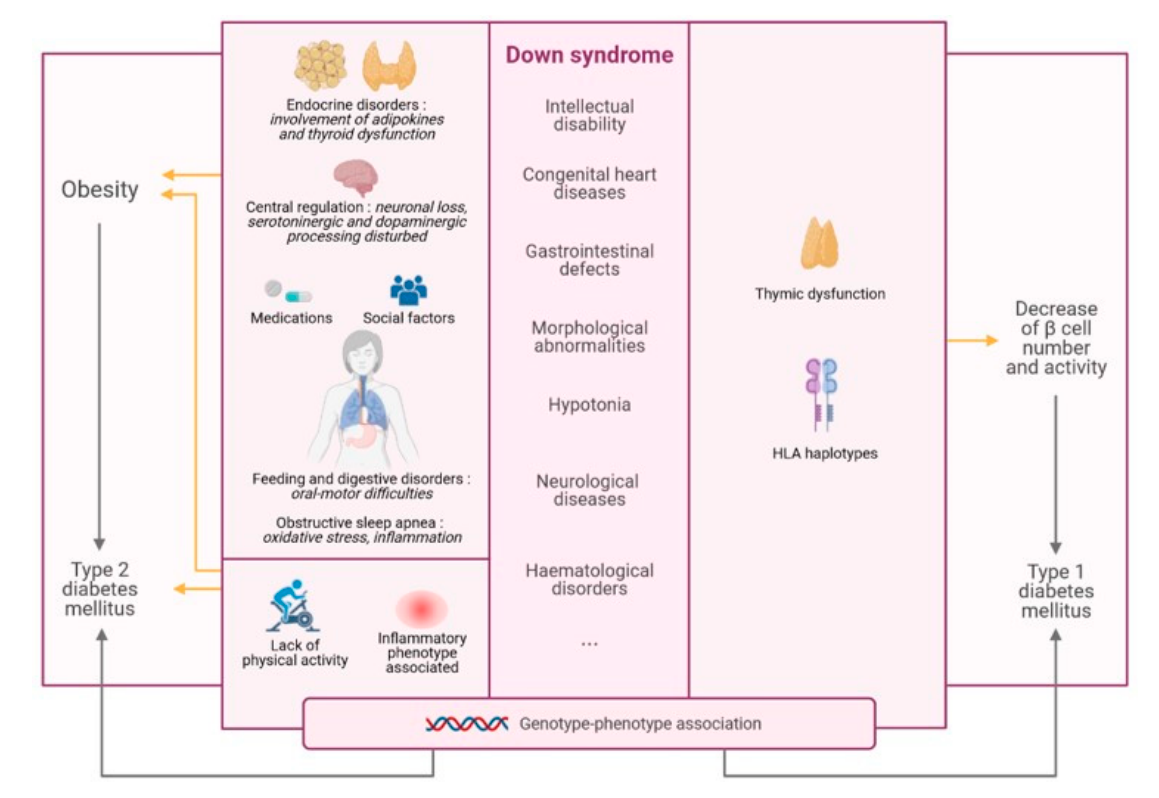
Figure 1. Link between Down syndrome (DS) and metabolic